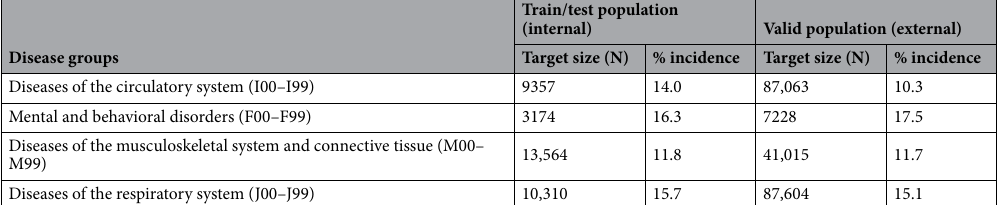
Table 2. Number of visits in each disease group and outcome incidence rate in our research